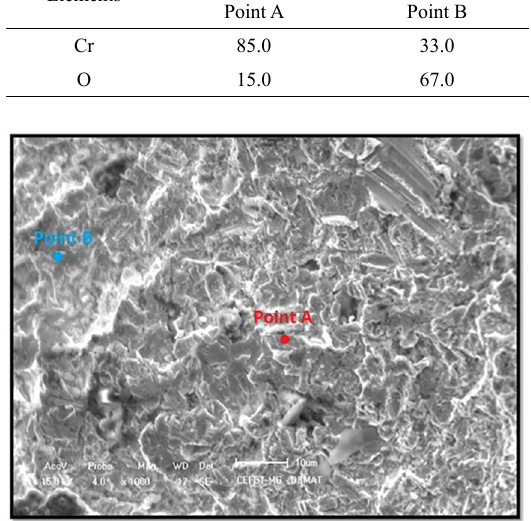
Figure 4. Microstructure of the sample 5 coated with black